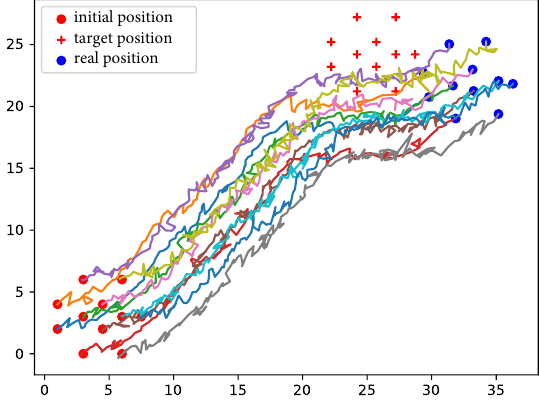
Figure 11. Moving node trajectory projections (km).